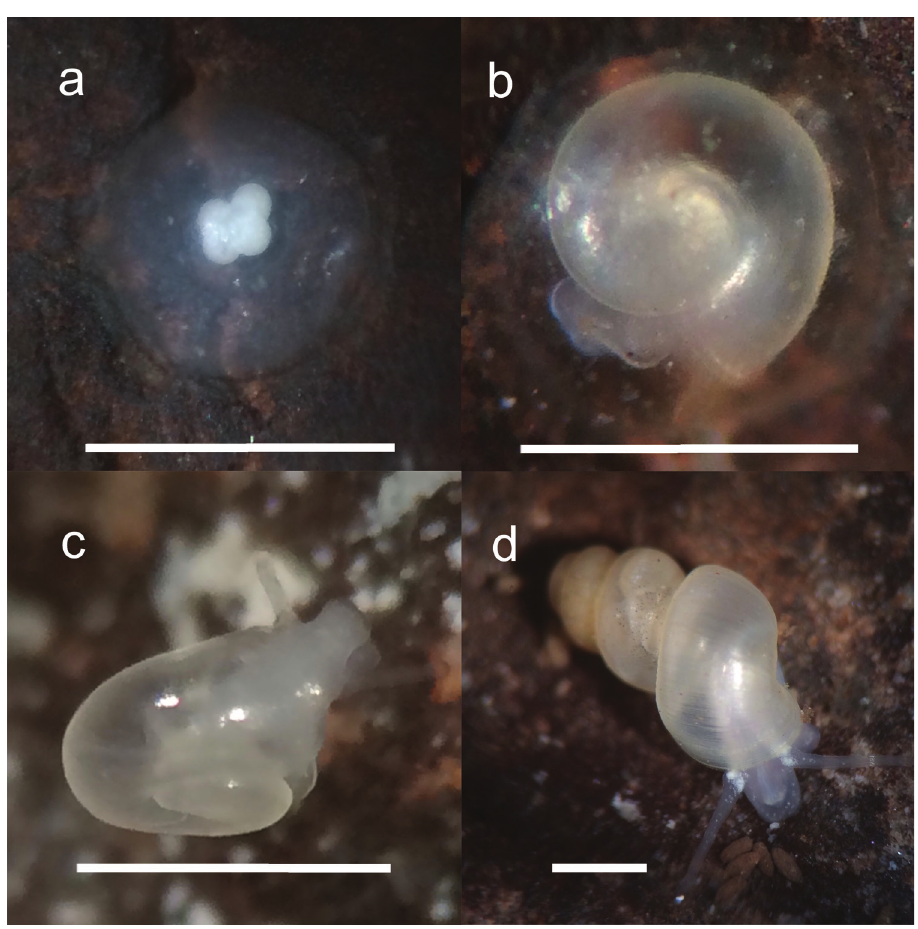
Figure 2. Life stages of Fontigens antroecetes observed under simulated cave conditions in the laboratory a egg capsule containing two-day old embryo at the four-celled stage b well developed embryo at 75 days development c newly hatched snail d adult lab raised individual. Scale bars represents approximately 1